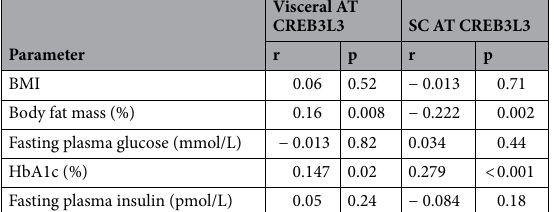
Table 1. Univariate correlation analyses (Pearson) of CREB3L3 human adipose tissue gene expression and metabolic traits.